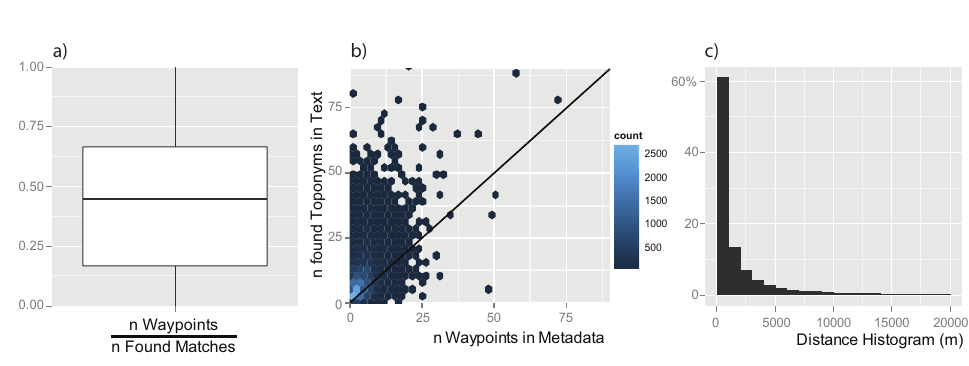
Figure 5: a: Box plot of ratio between waypoints in metadata and toponyms found in text documents; b: relationship between waypoints in metadata and toponyms found in text documents; c: histogram of distances between nearest waypoint and toponyms found in each